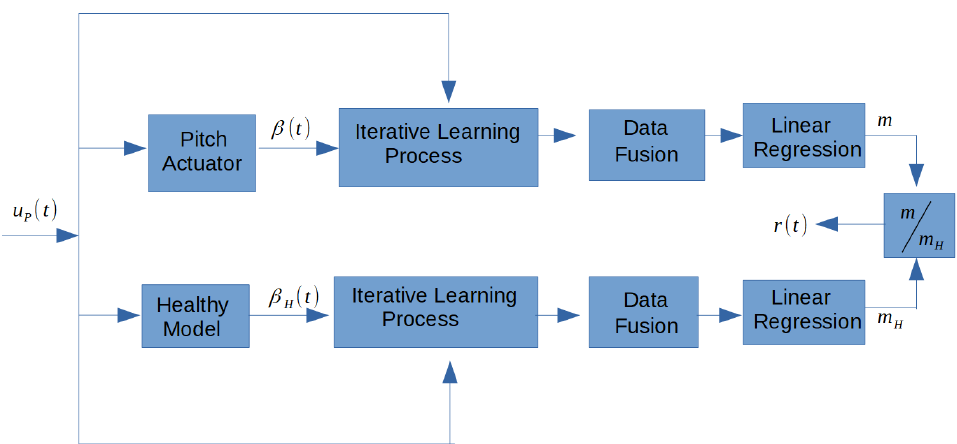
Figure 1. Residual signal r ( t ) for fault diagnosis based on an interactive learning process. The iterative learning process is as stated in Theorem 1. The linear regression block is a post-processing unit that is enabled after the end of the elapsed time for the test. Subscript H refers to the nominal scenario H in Table